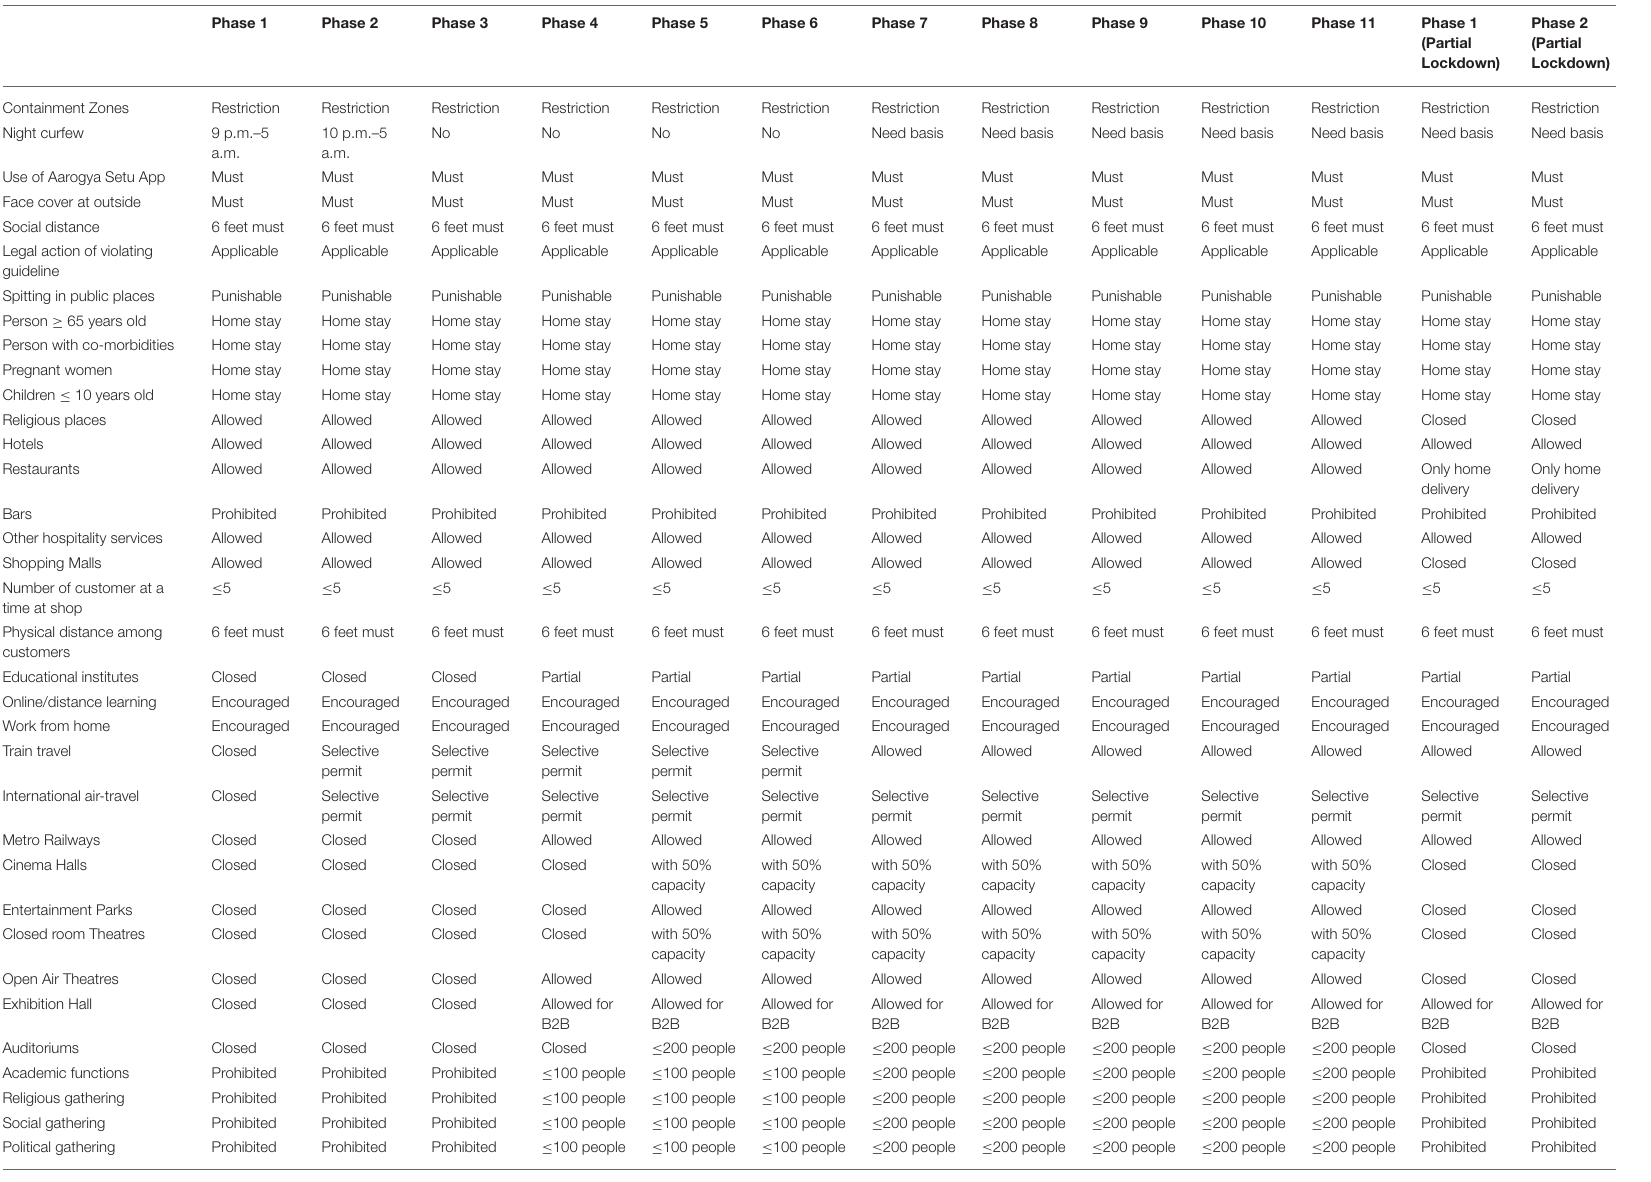
TABLE 1 | Summary of guidelines for unlock and partial lockdown